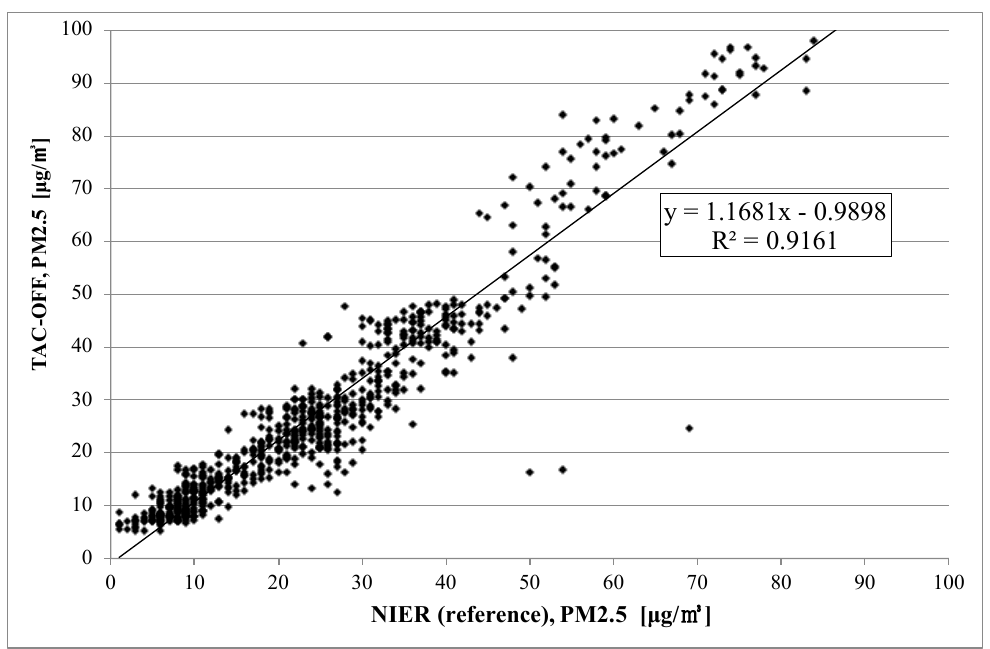
Figure 7. Correlation between TAM with TAC-on and the reference method (BAM) from 1–30 November 2021.